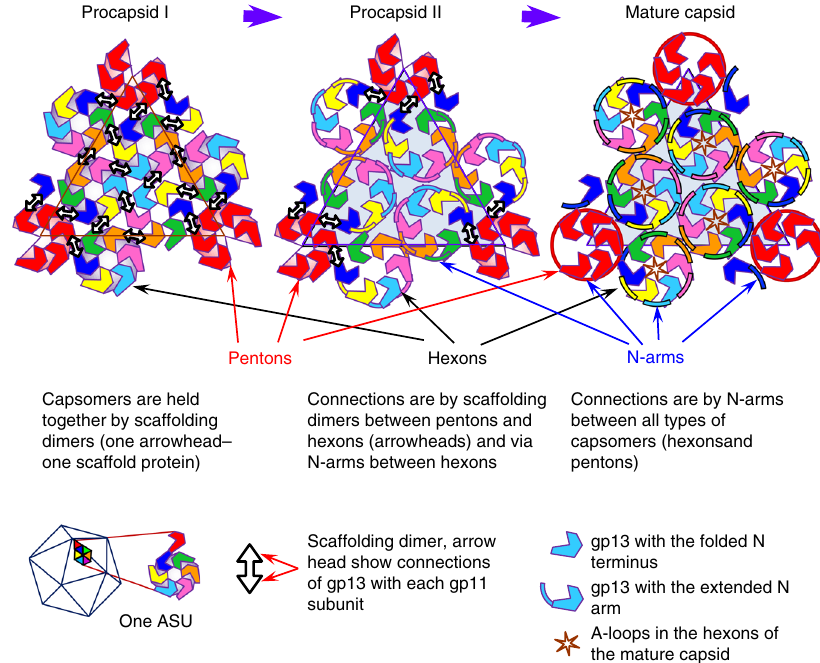
Fig. 5 Schematic representation of the maturation process of the SPP1 capsid. The left panel represents procapsid I where the capsomeres are fastened together by SP dimers (double head arrows). Pentons, located on the fi vefold vertices of the capsid, are shown as red hexamers with one subunit omitted. The middle panel shows procapsid II where SP dimers remain only around pentons. Hexons are held together via extended N-arms. The MCV is shown on the right panel. Capsomeres are connected through extended N-arms. The central opening in hexons is closed by A loops indicated by stars. Colour coding of the MCP subunits is as in Fig.